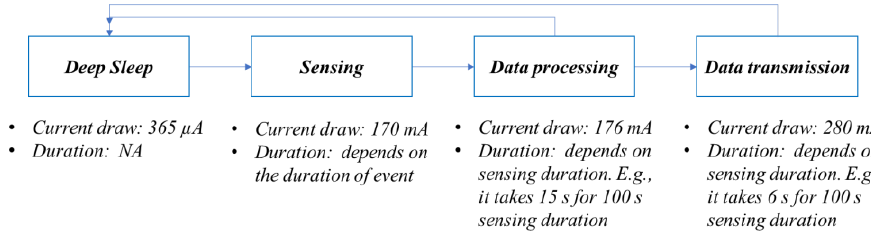
Figure 10. Flowchart of event-triggered sensing regarding current draw and duration for each operation.